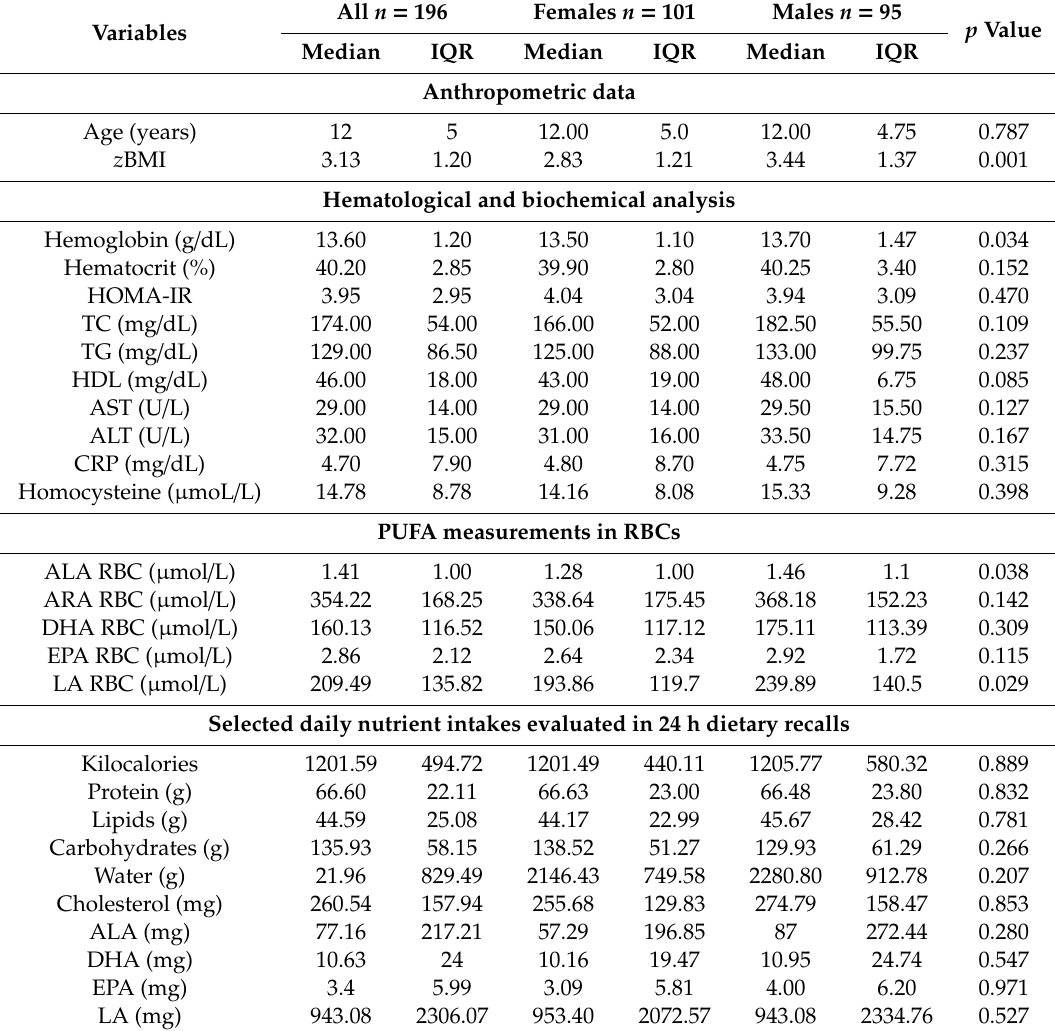
Table 1. Descriptive statistics for anthropometric data, biochemical analysis, PUFA measurements in RBCs, and dietary intakes. Mann–Whitney U test was used to analyze gender di ff erences (test is significant at p value ≤